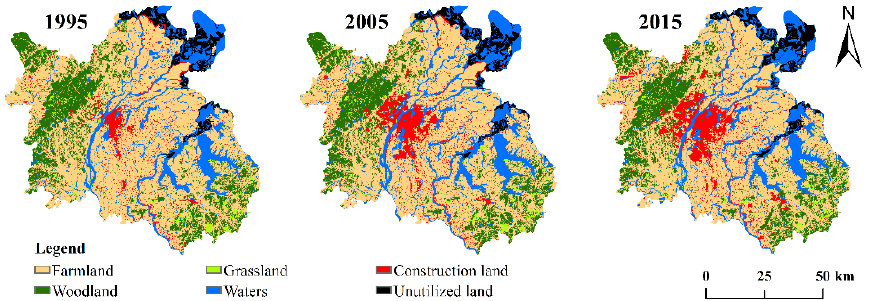
Figure 2. Spatial distribution patterns of landscape types in 1995, 2005, and 2015.